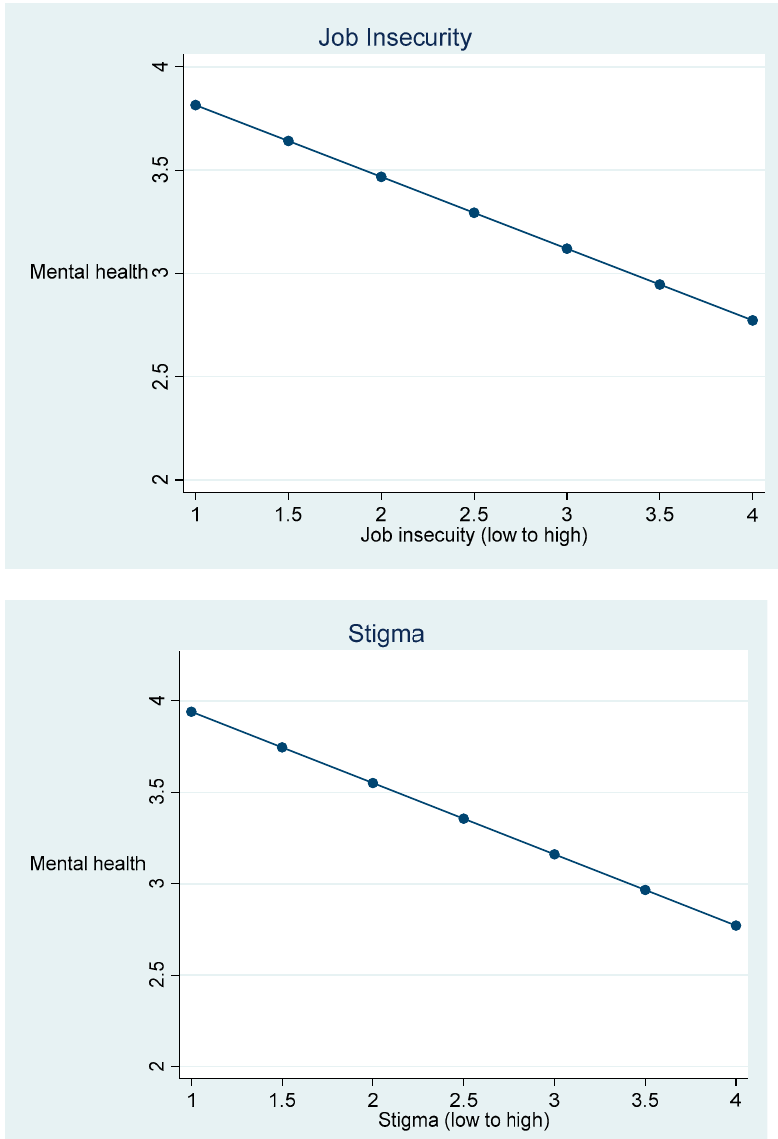
Figure 2. Predicted values, mental health, and job attributes in hairstyling.